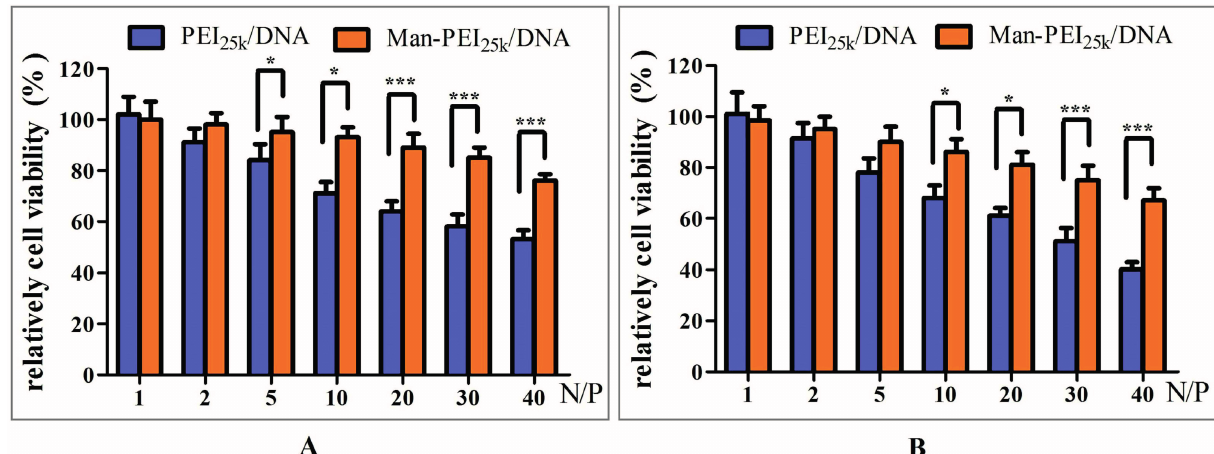
Figure 5. Cytotoxicities of the complexes at various N/P ratios in ( A ) DC2.4 and ( B ) HeLa cells by MTT assay. Each data point represents the mean value ± standard deviation ( n = 6). *** p < 0.01, * p <